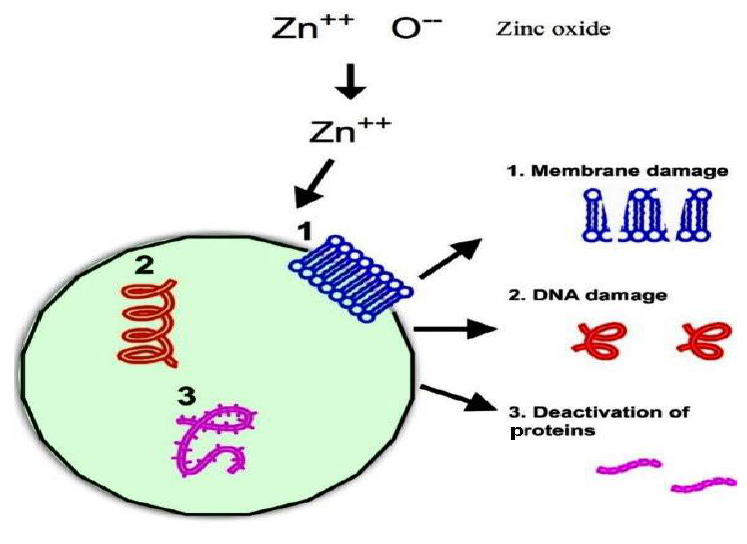
Figure 8. Biological activity mechanism of ZnO nanoparticles.